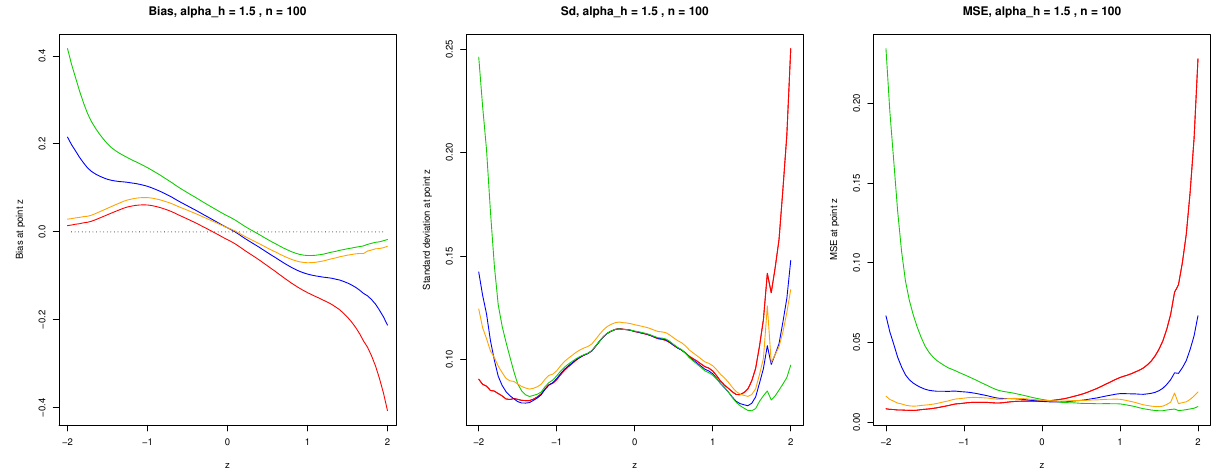
Figure 3: Local bias, standard deviation and MSE for the estimators ˆ τ (1) (red) , ˆ τ (2) (blue), ˆ τ (3) (green), ˜ τ (orange), with n = 100 and α h = 1.5 in Setting 2. The dotted line on the first figure is the reference at 0.